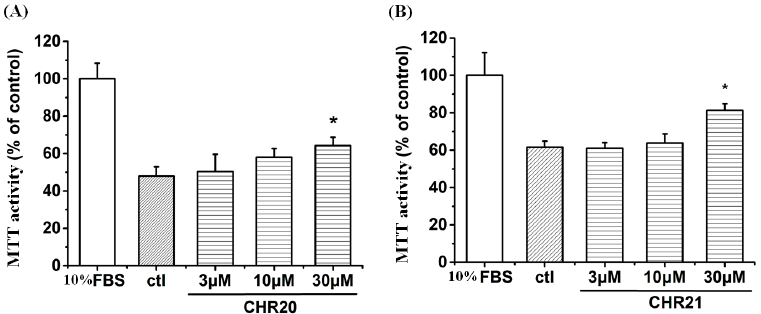
Figure 3. Cytotoxicity and MTT activity of CHR20 and CHR21 on RGC-5 cells. Cells that were cultured in RPMI-1640 medium with low serum (0.2% of FBS) for 24 h were set as the control group. RGC-5 cells with 0.2% FBS were treated with CHR20 ( A ) and CHR21 ( B ) at concentrations of 3, 10 and 30 μ M, respectively for 24 h. Cell viability was determined by MTT assay and presented as mean ± SD for six replicates. * p < 0.05 vs. control group.